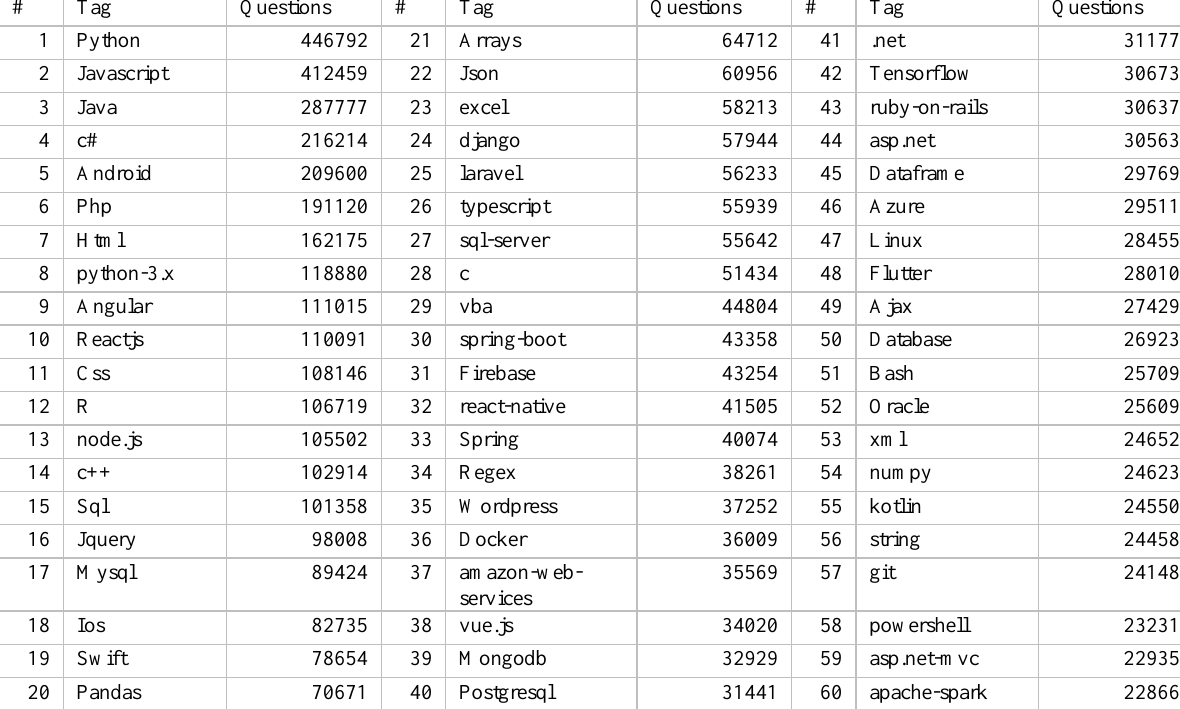
Table 4. Top 60 Tags and frequencies between